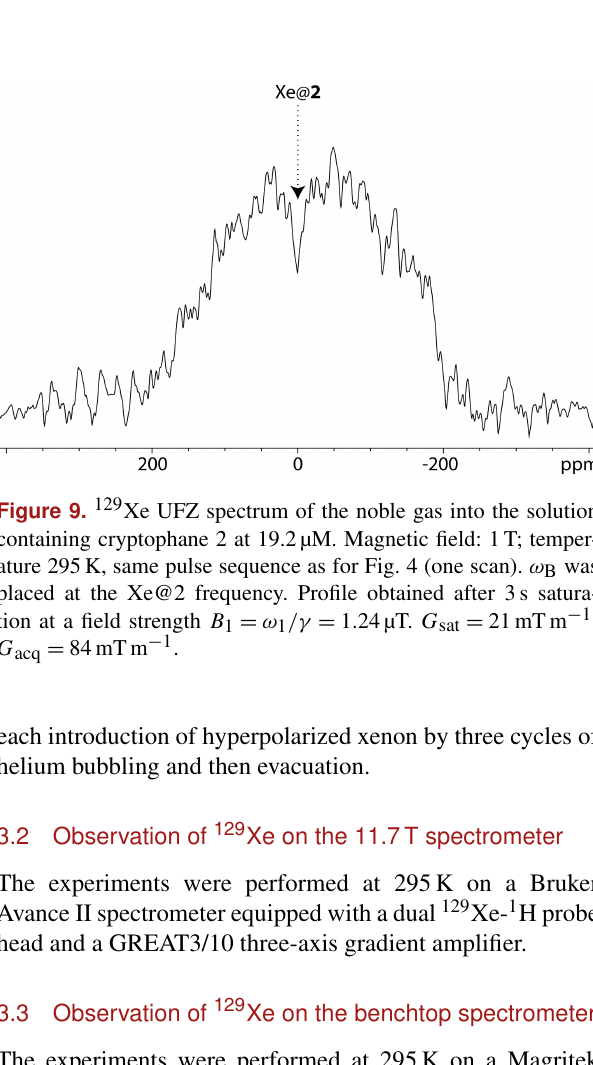
Figure 7. Simulation of 129 Xe Z spectra at 11.7 (green) and 1 (purple) Tesla. (a) Considering the same relaxation times, same rf field strength and duration of the saturation; (b) considering a saturation of lower amplitude but larger duration for the low-field experiment. Details of the conditions for the simulation: see text.